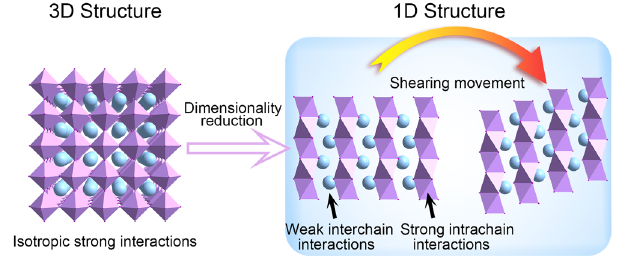
Fig. 1 | Design strategy for martensitic transformation systems. Dimensionality reduction strategy for the design of martensitic actuators by facilitating shearing